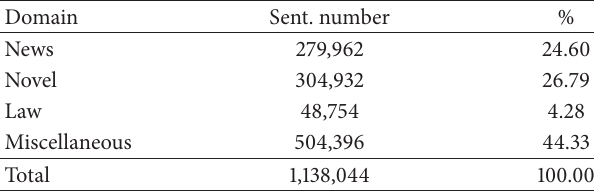
Table 1: Proportions of domains of general